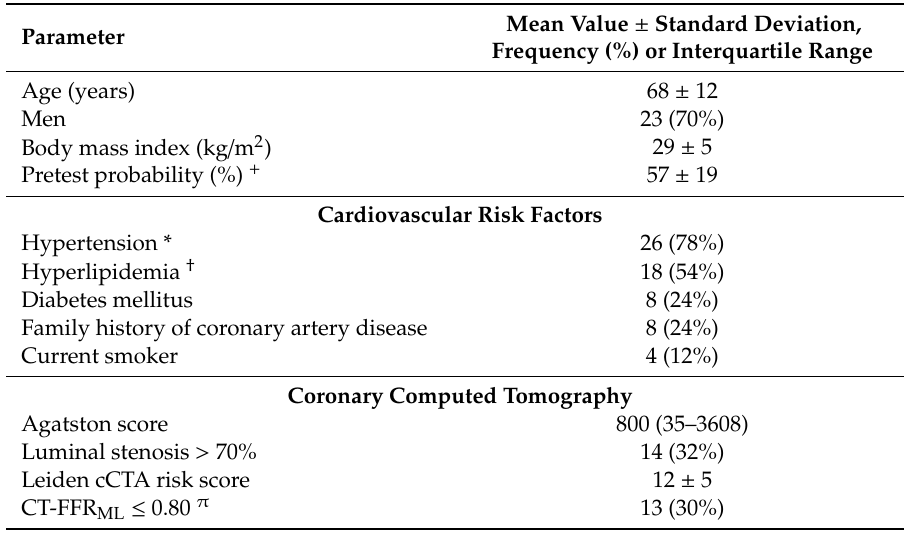
Table 1. Baseline characteristics (patients n = 33 and lesions π n = 44) and findings of cCTA, CT-FFR ML , and